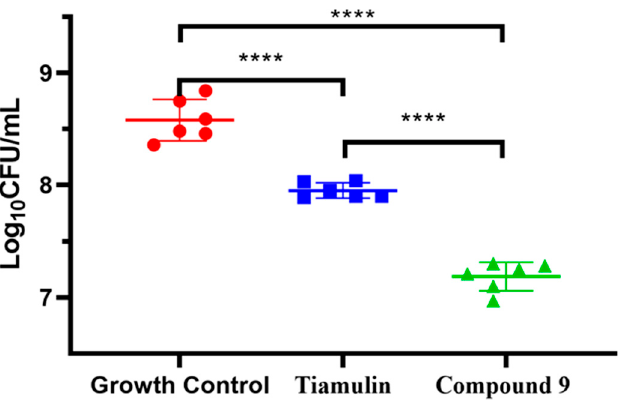
Figure 5. In vivo efficacy of Tiamulin (20 mg/kg) and compound 9 (20 mg/kg) in neutropenic mice thigh infection model. The mean log10 CFU is plotted of mice thigh after treatment with Tiamulin and compound 9 . The **** means significant difference.